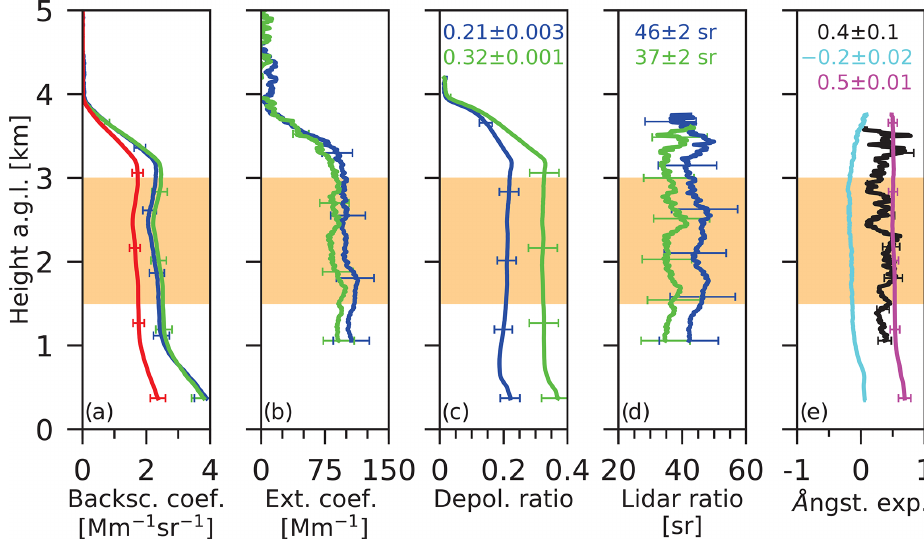
Figure 1. Profiles of optical properties measured on 11 June 2015, 18:00–20:59UTC. (a) Particle backscatter coefficient at 355 (blue), 532nm (green), and 1064nm wavelength; (b) particle extinction coefficient at 355 (blue) and 532nm (green); (c) particle linear depolarization ratio at 355 (blue) and 532nm (green) wavelength; (d) lidar ratio at 355 (blue) and 532nm (green) wavelength; (e) extinction-related Ångström exponent (black), backscatter-related Ångström exponent for the 355–532 (light blue), and 532–1064nm (magenta) wavelength ranges. The horizontal orange area indicates the averaging height range from 1.5 to 3km height. All profiles were calculated with the same 743m vertical smoothing length. Numbers in (c) , (d) , and (e) show mean values for the orange layer and respective standard deviations. Error bars show the measurement uncertainties in the height